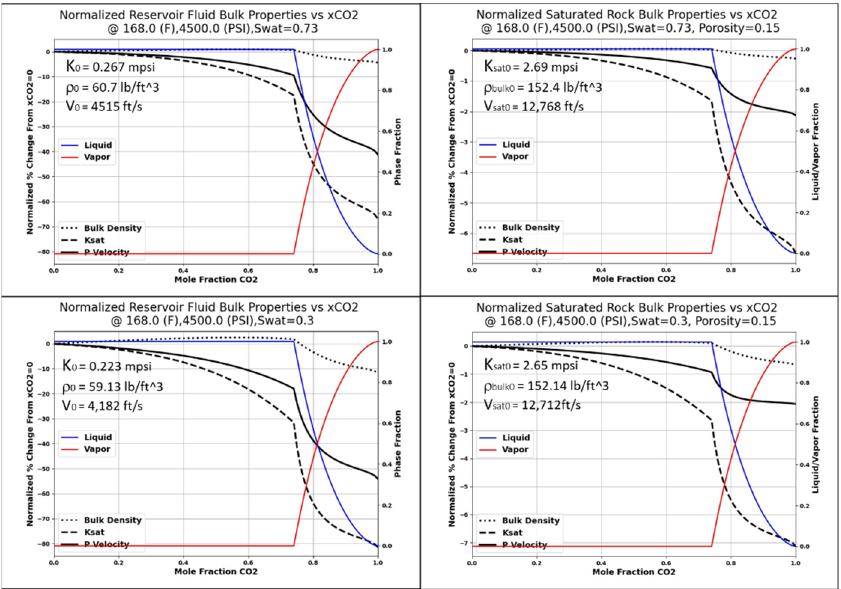
Figure 16. Normalized reservoir fluid ( left ) and saturated rock ( right ) elastic properties for stiff fluid scenario where Swat = 1-Sor and xCO2 = 0 ( top ), and soft fluid scenario where Swat = Swirr ( bottom ) at nominal conditions (T = 168 °F, p = 4500 psi, and φ = 0.15).